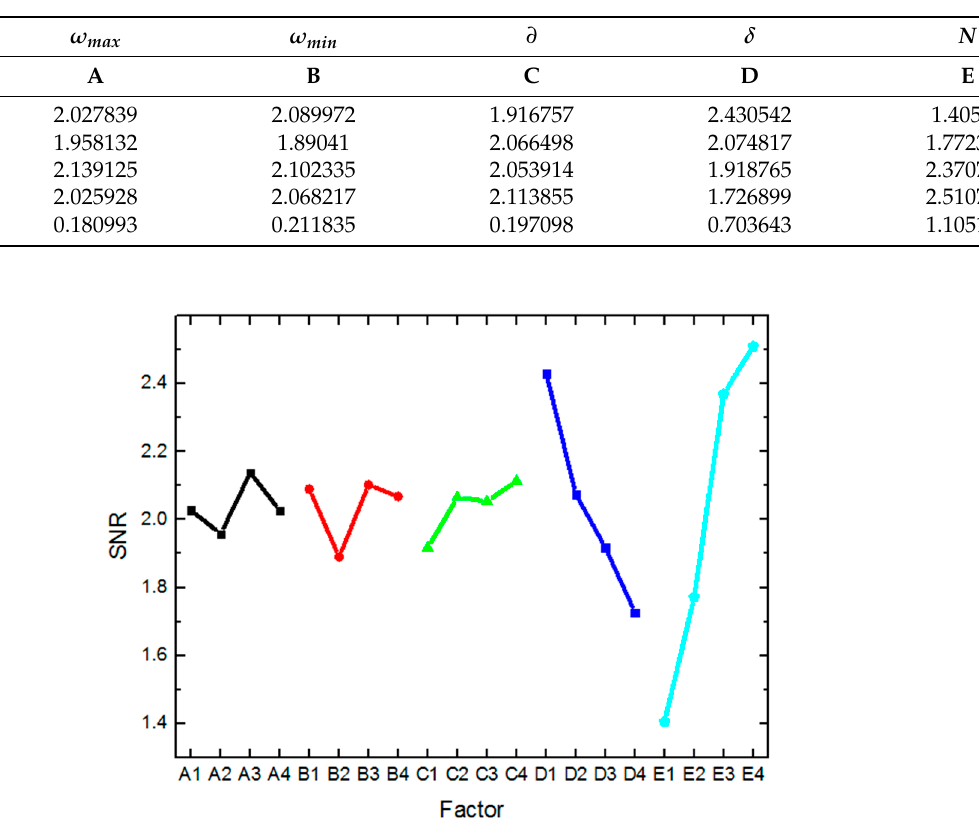
Table 6. Factor response table.